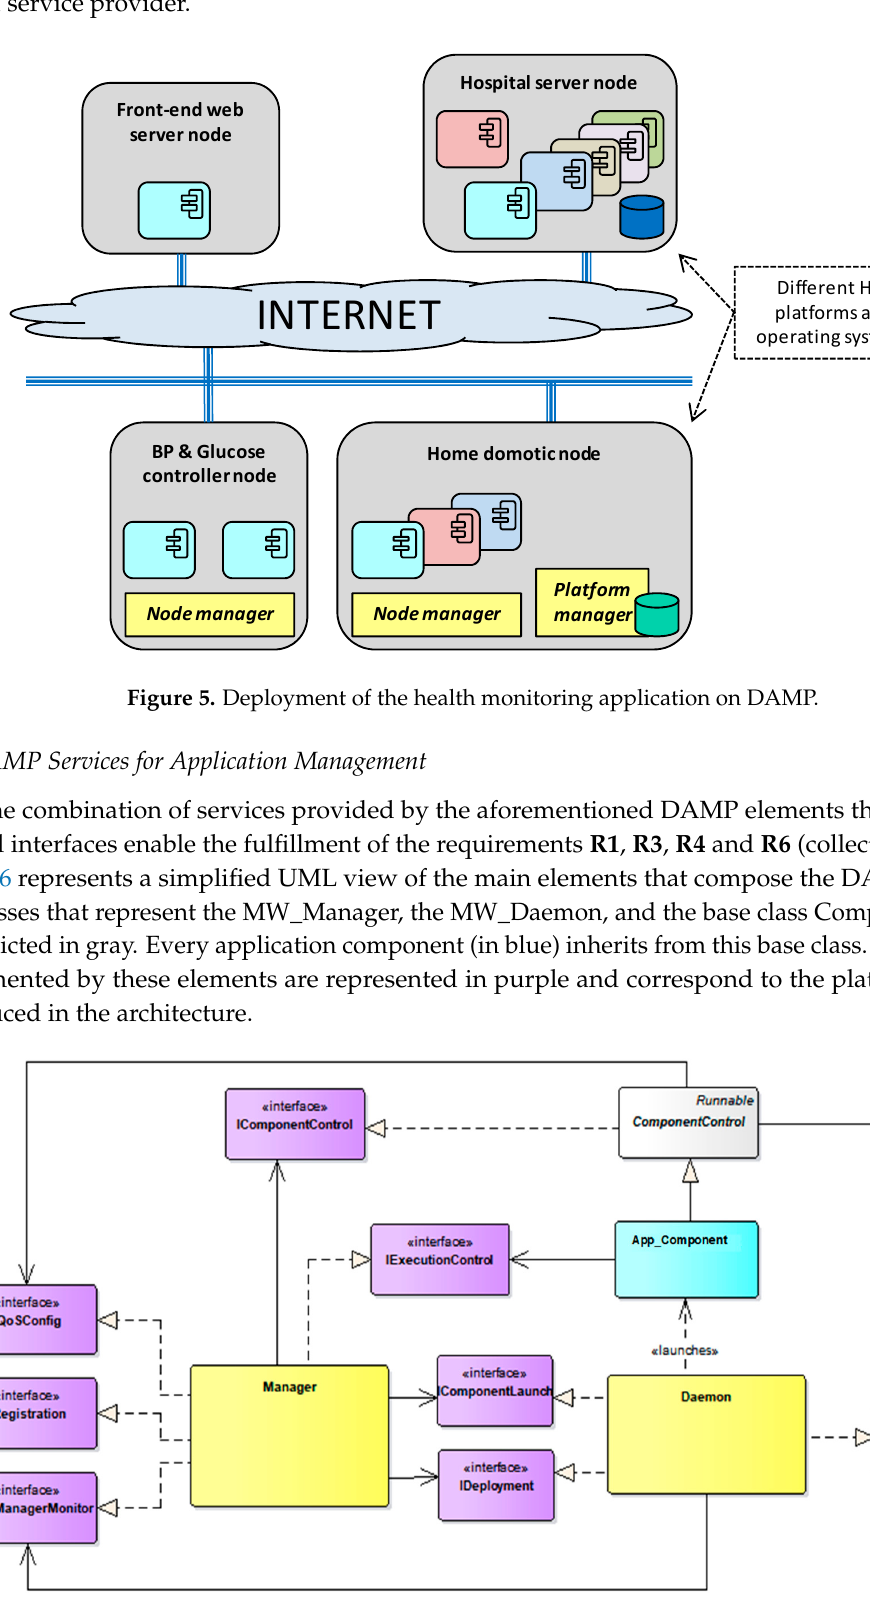
Figure 6 . Main elements of the DAMP platform.